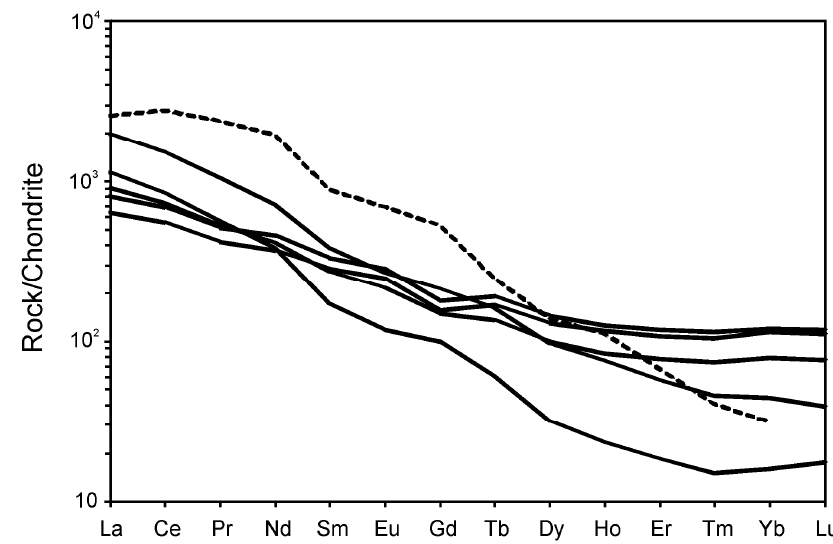
Figure 6. Chondrite normalized REE patterns of the silicocarbonatite from Breivikbotn. Curve for average carbonatite [32] is dotted and shown for reference. Chondrite composition is taken from [30].